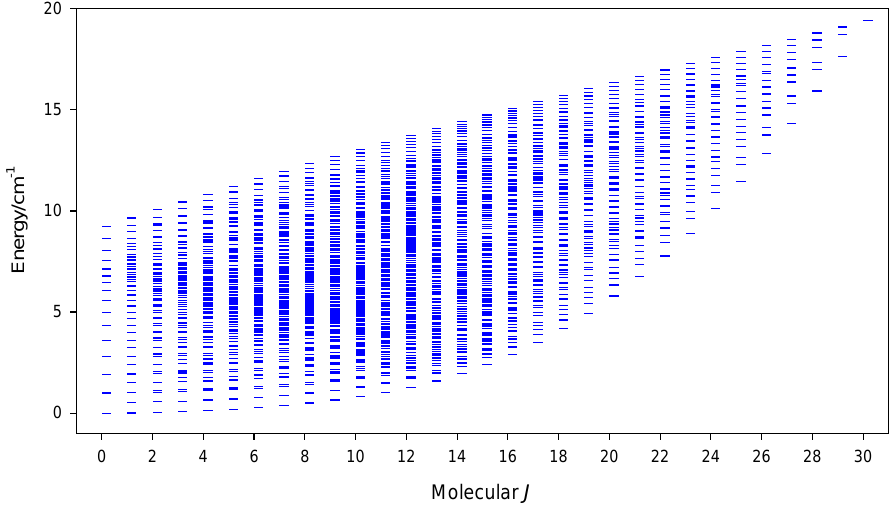
Figure 4. Calculated energy spectrum of 1 .